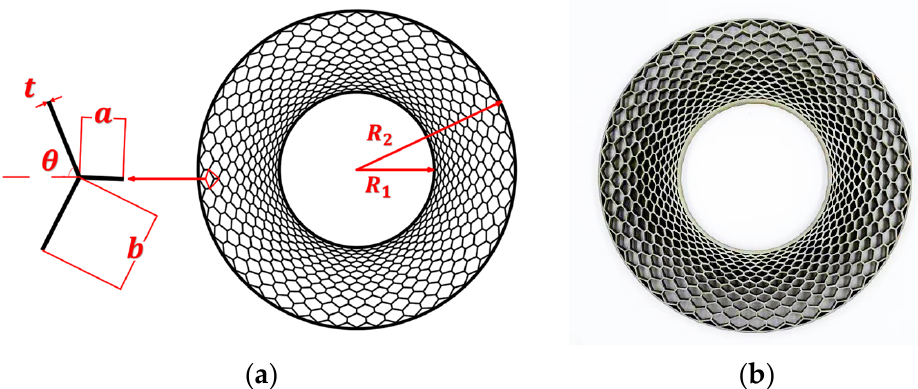
Figure 2. Test model diagram. ( a ) Schematic diagram of test model structure and cells; ( b ) physical map of the test model.